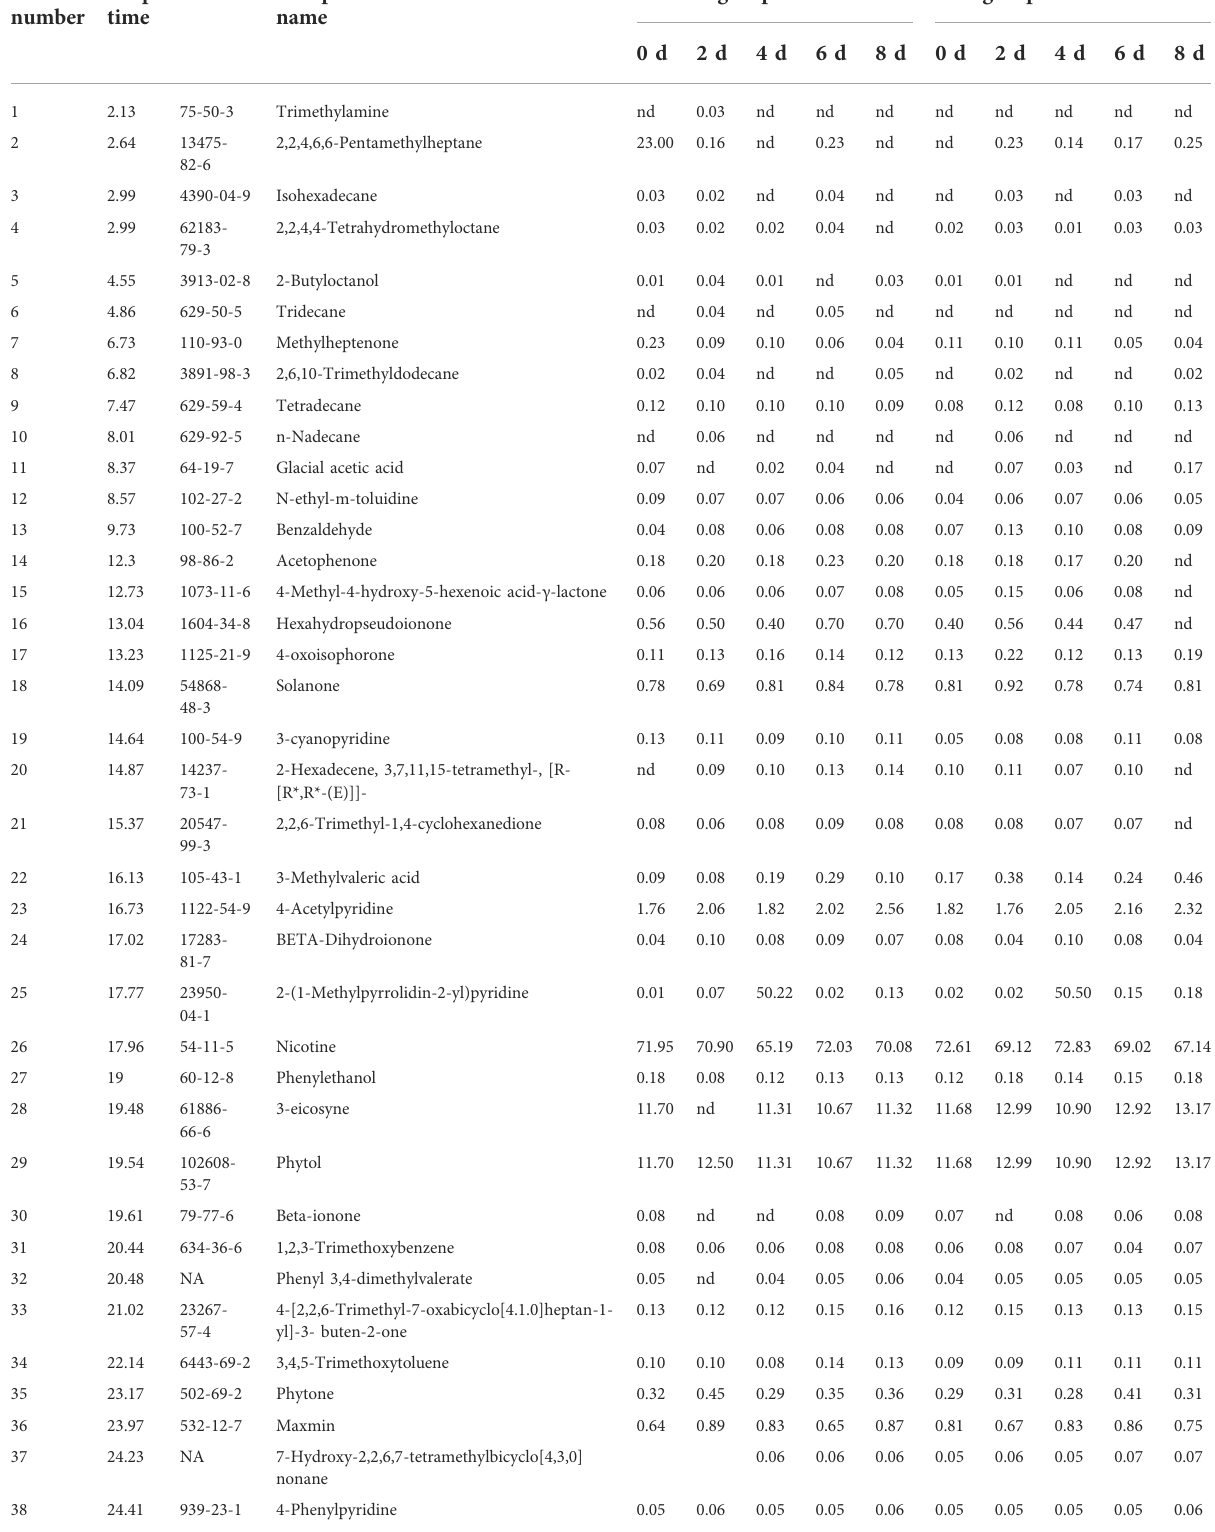
TABLE 5 Brazil Frogstrips YA14 Main compounds change during smoke core